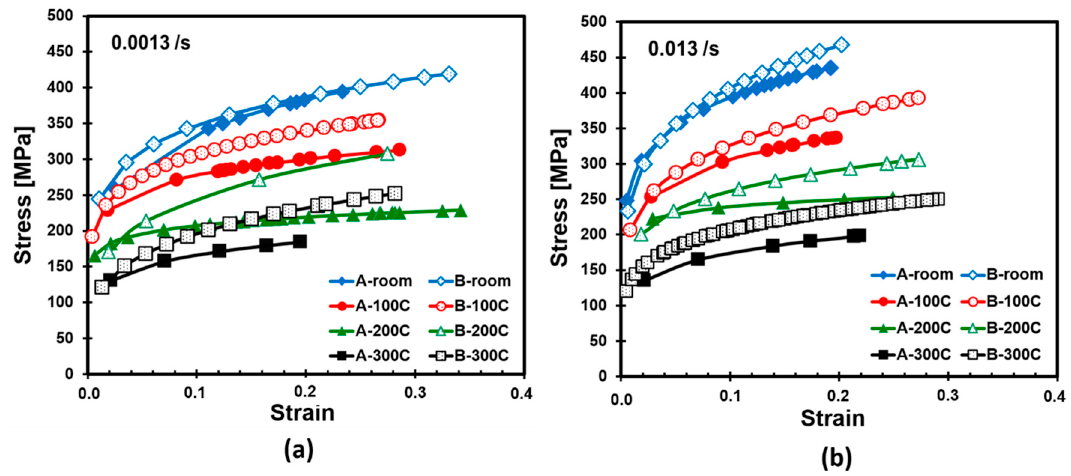
Figure 4. Stress-strain curves based on tensile tests for thin titanium foil at ( a ) 0.0013 / s and ( b ) 0.013 / s loading strain rates.